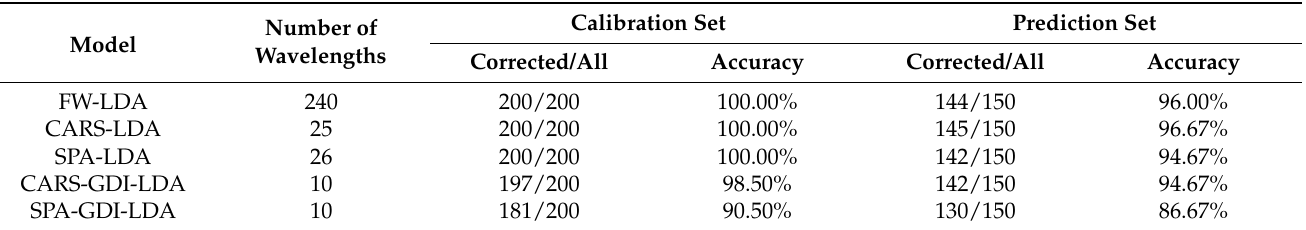
Table 2. Results of model test under full wavelength and different characteristic wavelength selec- tion modes.